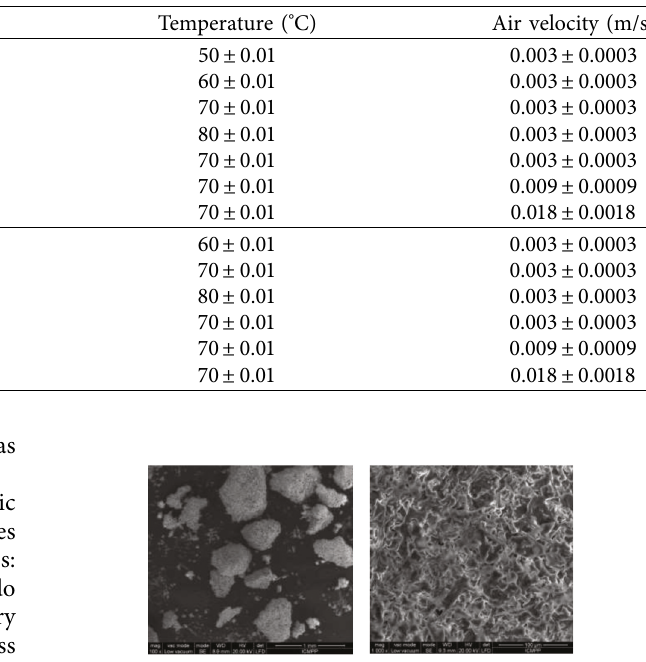
Figure 1: SEM images of dry spent coffee grounds particles. (b) The SEM image for spent coffee grounds particles registered at mag- nitude 1000x and indicates a “sponge-like” aspect. Based on this image, pore sizes were measured and found to vary between 8 ± 0.08 μ m and 17 ± 0.17 μ m, with an average value of 12.4 ± 0.12 μ m. Zein et al. have also reported in the literature pores with dimensions up to 30 μ m for dry spent coffee grounds [18]. Le et al. also reported values for spent coffee grounds pore size not exceeding 30 μ m